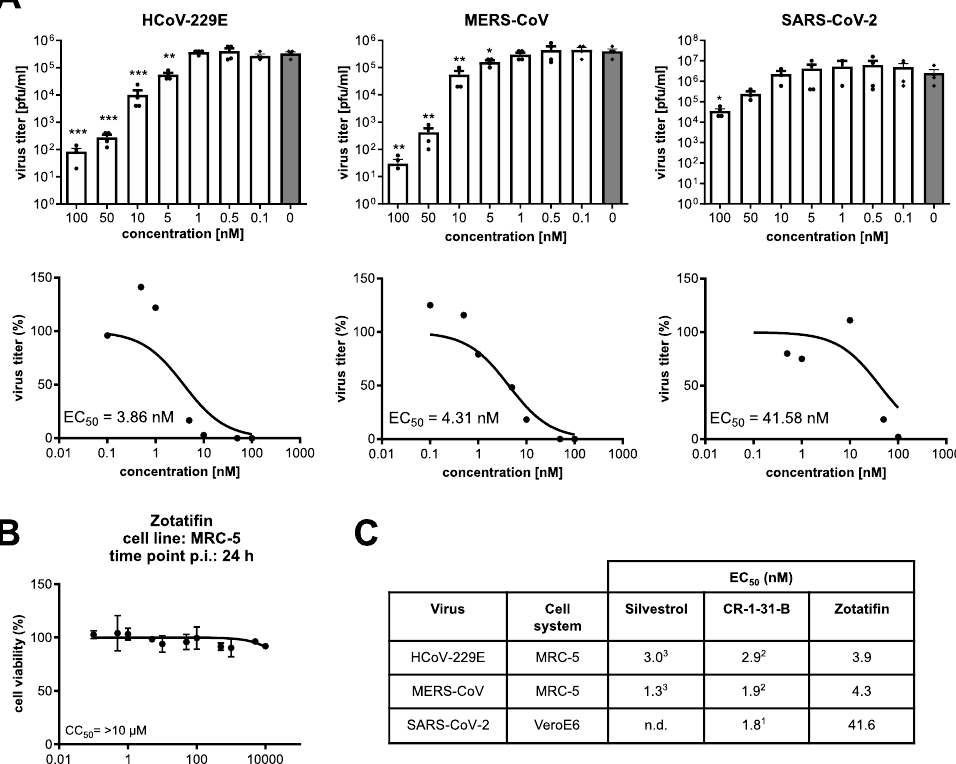
Figure 5. Antiviral activity of zotatifin against different CoVs and comparison with silvestrol and CR-1-31-B. ( A ) MRC-5 or Vero E6 cells were infected with an MOI of 0.1 with HCoV-229E (MRC-5 cells), MERS-CoV (MRC-5 cells) or SARS-CoV-2 (Vero E6 cells) for 24 h in the presence of indicated concentrations of zotatifin or solvent control. Significance levels compared to the results for untreated cells are indicated as follows: *, p < 0.05; **, p < 0.005; ***, p < 0.0005. Error bars show SEM. ( n ≥ 3). ( B ) Viability assay (MTT assay) of MRC-5 cells treated for 24 h with the indicated concentrations of zotatifin. ( C ) Overview of EC 50 values against CoVs measured in the present study or reported previously (as described in 1 = [21]; 2 = [20]; 3 = [19]); n.d.: not